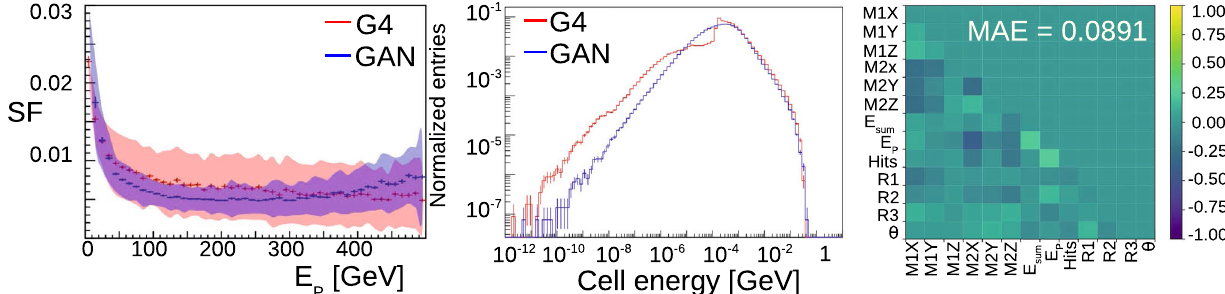
Fig. 17 Shower features for GAN vs. GEANT4 charged pion events. (Left) SF as a function of E P with shaded area representing standard deviation. (Mid) pixel intensities with log yscale. (Right) difference between internal correlations among shower features